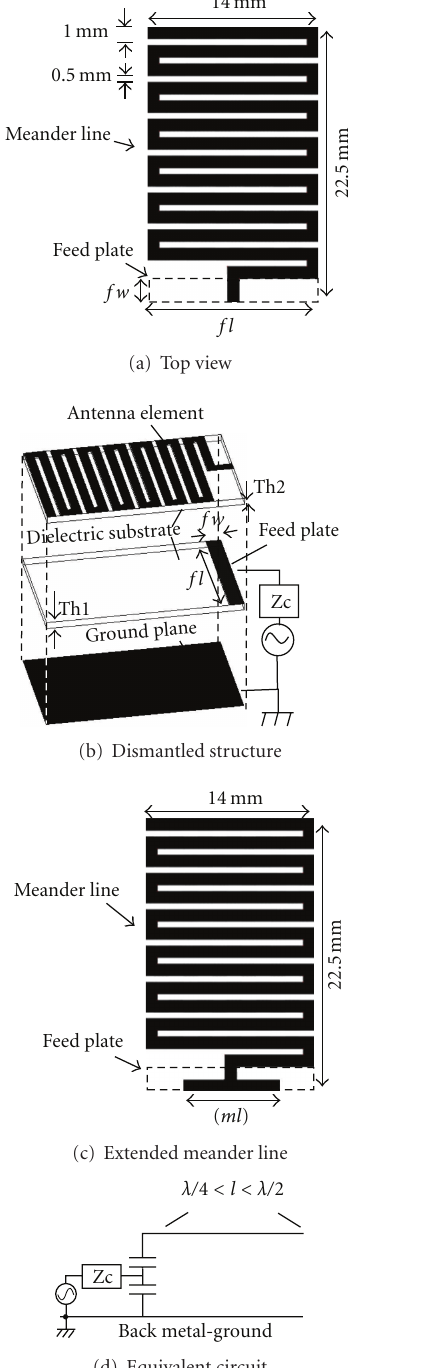
Figure 1: Small and low-profile capacitive feed meander line antenna (CFMA).